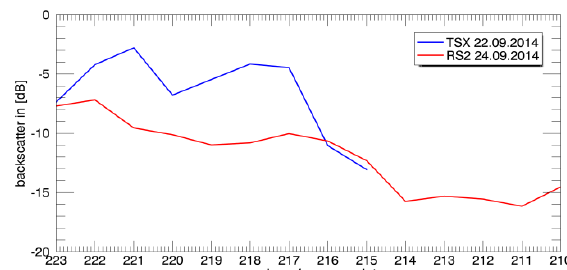
Figure 5. Profile near Sexenjoch (orange points in Figure 4) with the backscatter values of TSX image in blue and the backscatter values of RS2 image in red. Survey point 223 is located at 2904 m altitude, point 210 at 3260 m.